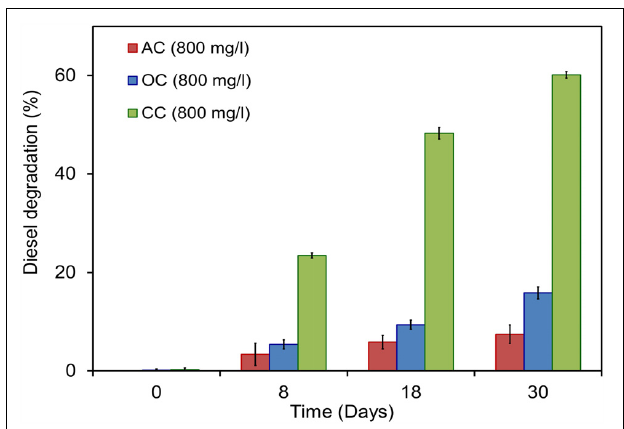
FIGURE 10 | Electrobioremediation of DRH by Citrobacter sp. KVM11. Pink bar represents the percent of hydrocarbon removal in abiotic control samples containing 800 mg/l of DRH; Blue bar represents the percent of hydrocarbons removal in open circuit reactors containing 800 mg/l of DRH; Green bar represents the percent of hydrocarbons removal in closed circuit reactors containing 800 mg/l of DRH.